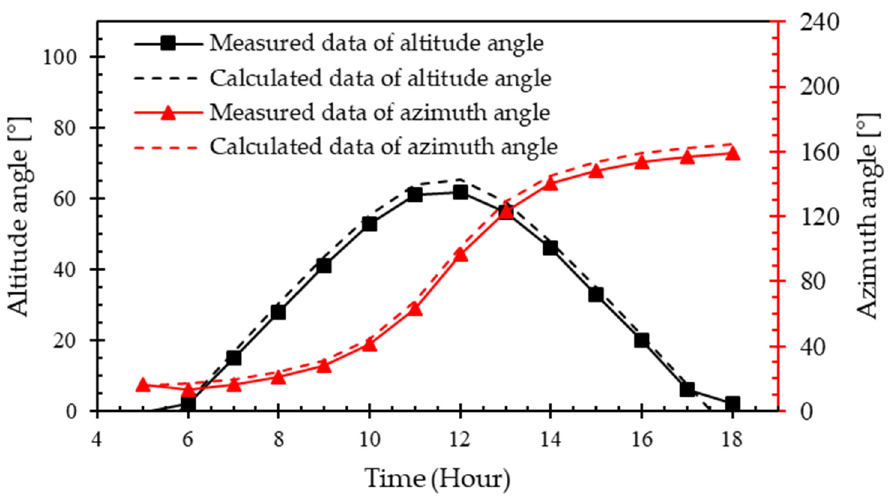
Figure 8 . Measured and calculated data [46] of the altitude and azimuth angle in the dual-axis solar tracking system .